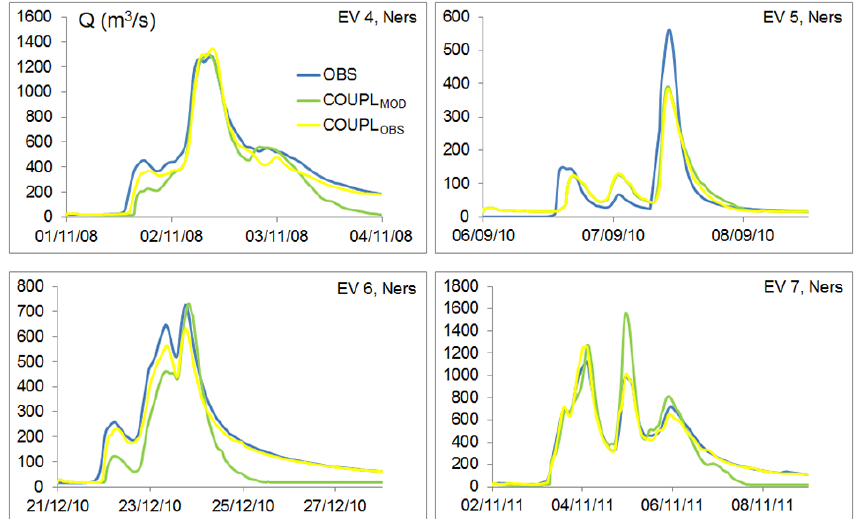
Figure 7. Hydrographs modelled for event nos. 4, 5, 6 and 7 according to the COUPL MOD and COUPL OBS modelling options, at the Ners